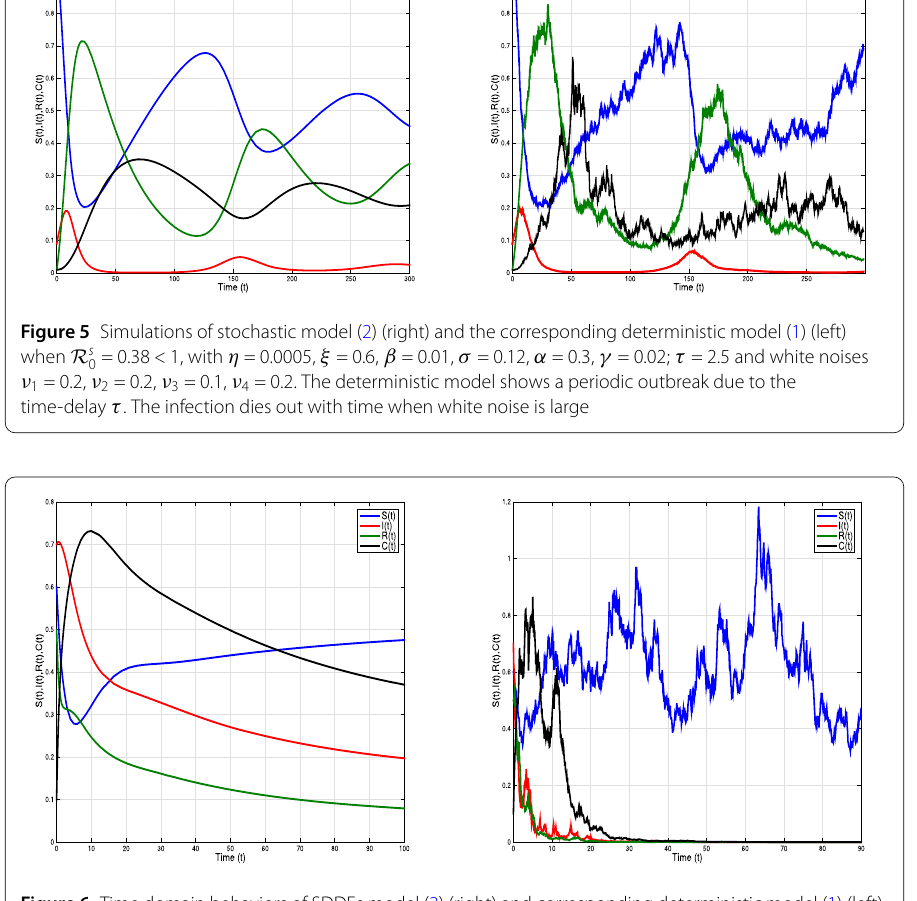
Figure 6 Time domain behaviors of SDDEs model (2) (right) and corresponding deterministic model (1) (left), where τ = 1, when R 0 = 1.78 > 1, the infection persists in the deterministic model; when R s 0 = 0.75 < 1, the infection dies out in the stochastic model. With parameter values η = 0.02, ξ = 0.5, β = 0.1, σ = 0.2, α = 0.26, γ = 1 and white noises ν 1 = 0.13, ν 2 = 0.54, ν 3 = 0.26, ν 4 =